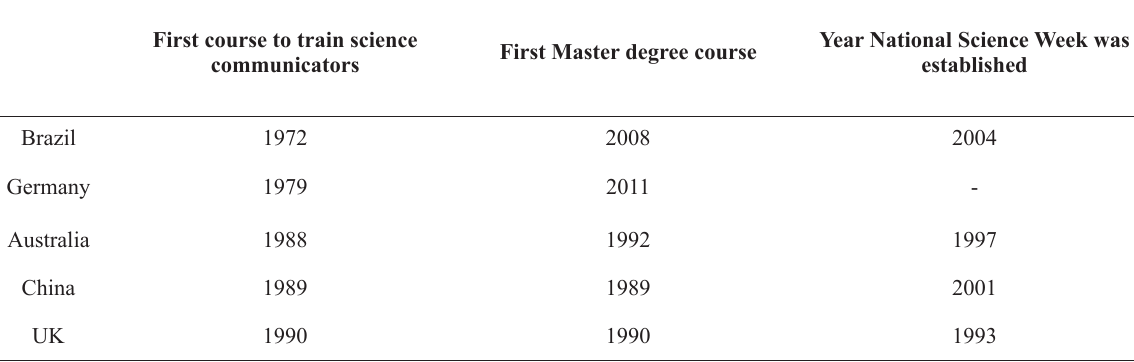
A sample of pioneer contributions in science communication in 5 countries. Source: Gascoigne (2014), based on data collected on panel discussions at PCST